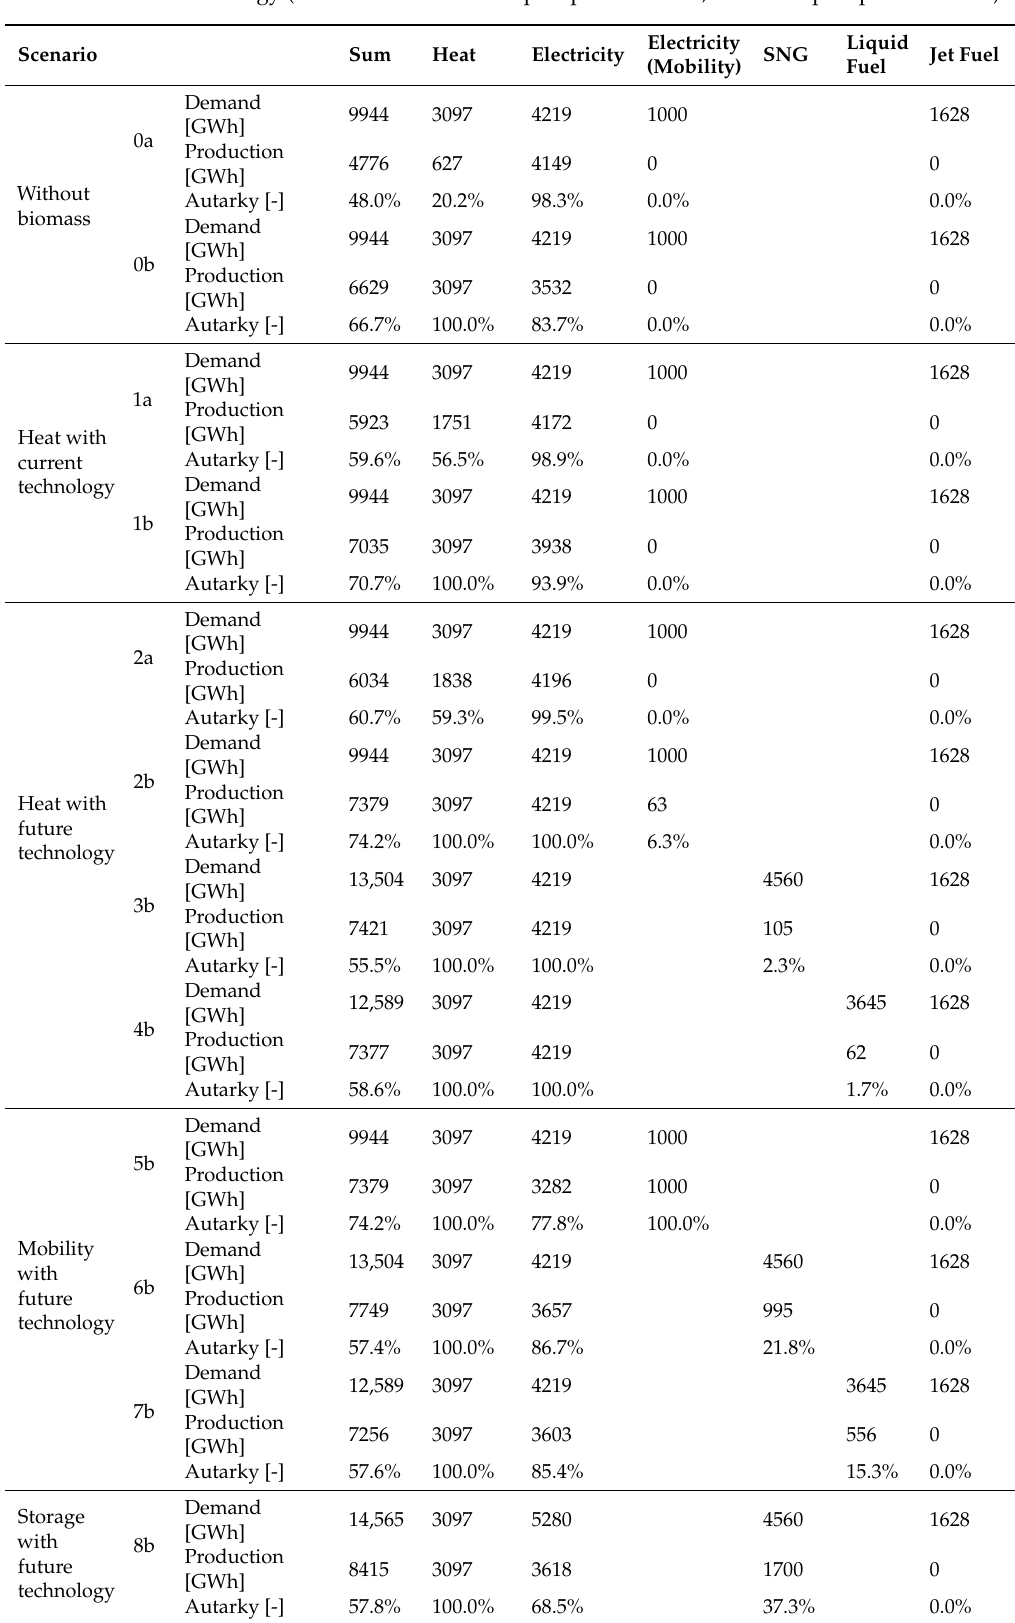
Table 5. Energy demand, production, and degree of self-su ffi ciency (autarky) of total energy demand for various forms of energy (scenarios without heat pumps 0a until 2a, with heat pumps 0b until